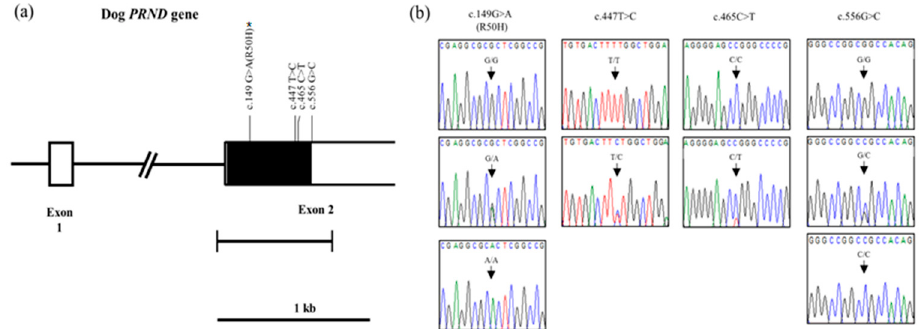
Figure 1. Gene map and polymorphisms identified in the dog prion-like protein gene ( PRND ) on chromosome 24. ( a ) The open reading frame (ORF) is indicated by a shaded block, and the 5 ′ and 3 ′ untranslated regions (UTRs) are indicated by white blocks. Horizontal bars with edges indicate the regions sequenced. Arrows indicate the novel polymorphisms found in this study. The asterisk indicates the nonsynonymous single nucleotide polymorphism (SNP) of the dog PRND gene. ( b ) Electropherogram of four novel SNPs: c.149G>A (R50H), c.447T>C (F149F), c.465C>T (A155A) and c.556G>C, identified in this study. Four colors indicate individual bases of DNA sequence using an ABI 3730 automatic sequencer (blue: cytosine, red: thymine, black: guanine, green: adenine). Among the four SNPs, c.149G>A (R50H) is a nonsynonymous SNP. Detailed values of the genotype and allele frequencies of the dog PRND gene are described in Table 1. Table 1. Genotype and allele frequencies of PRND polymorphisms in dogs.